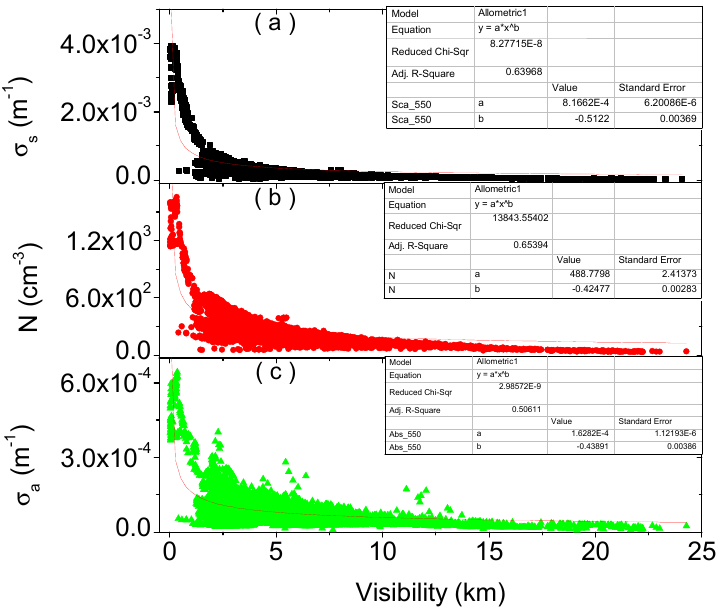
Figure 2. Temporal variations of visibilities, aerosol number concentrations (N), and scattering and absorption coefficients at 550 nm from 11 June to 30 June 2012, in Hefei.